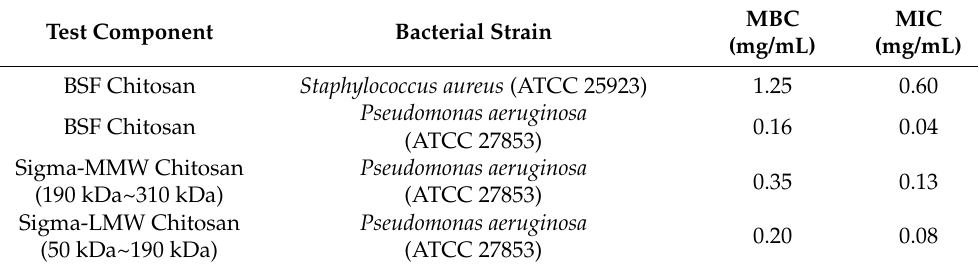
Table 3. The inhibition parameters of